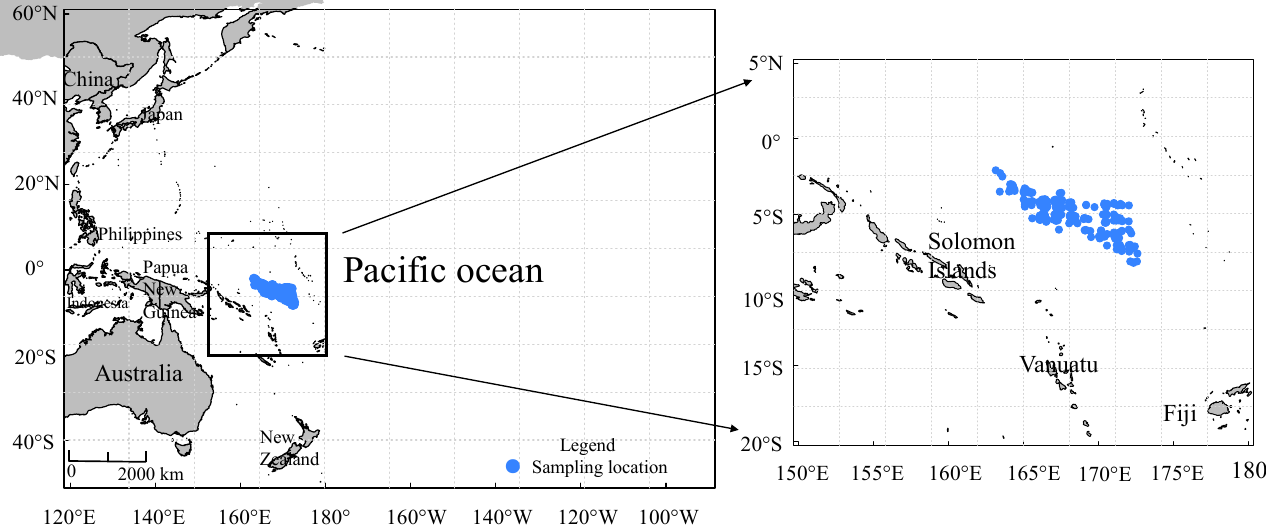
Figure 1. Tropical western and central Pacific Ocean showing sampling locations of T. albacares (blue closed circles).